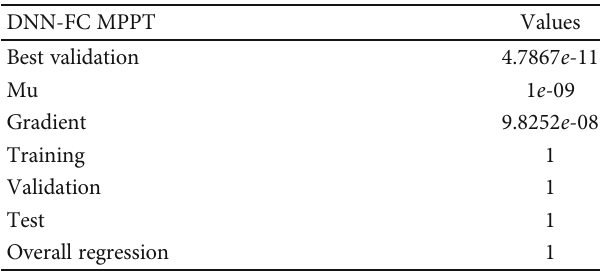
(a) DNN data of MPPT controller for PV systems